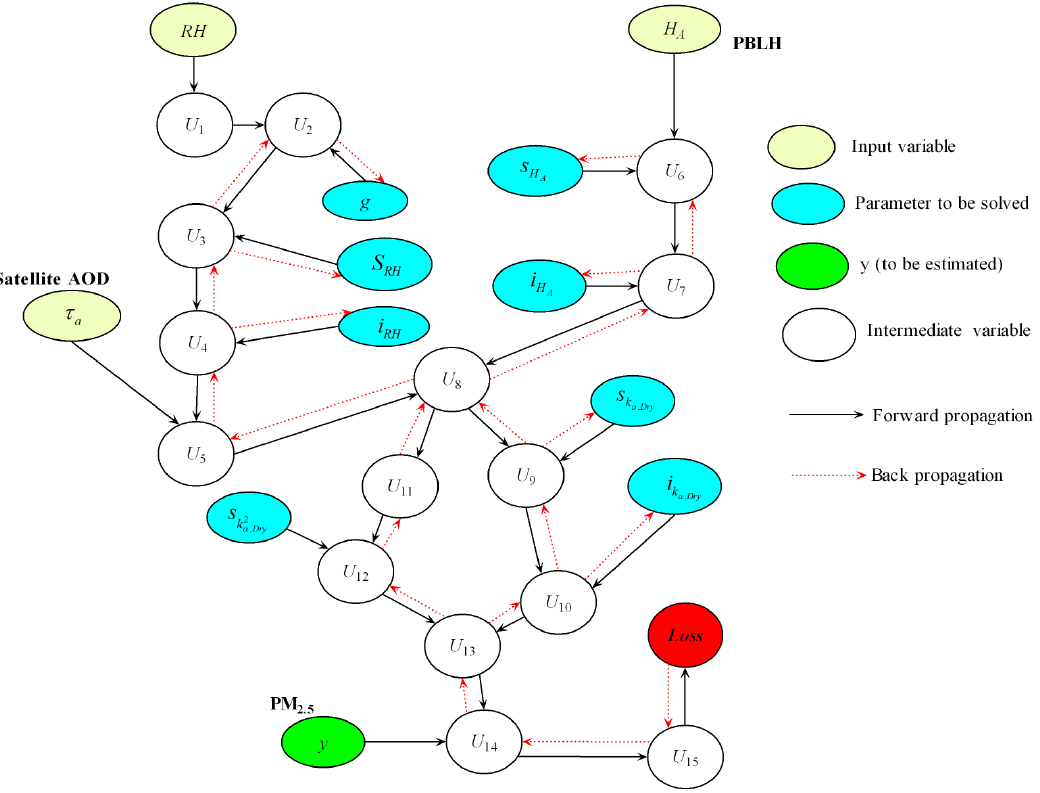
Figure 3. Computational graph of automatic differentiation to solve Equation (11).